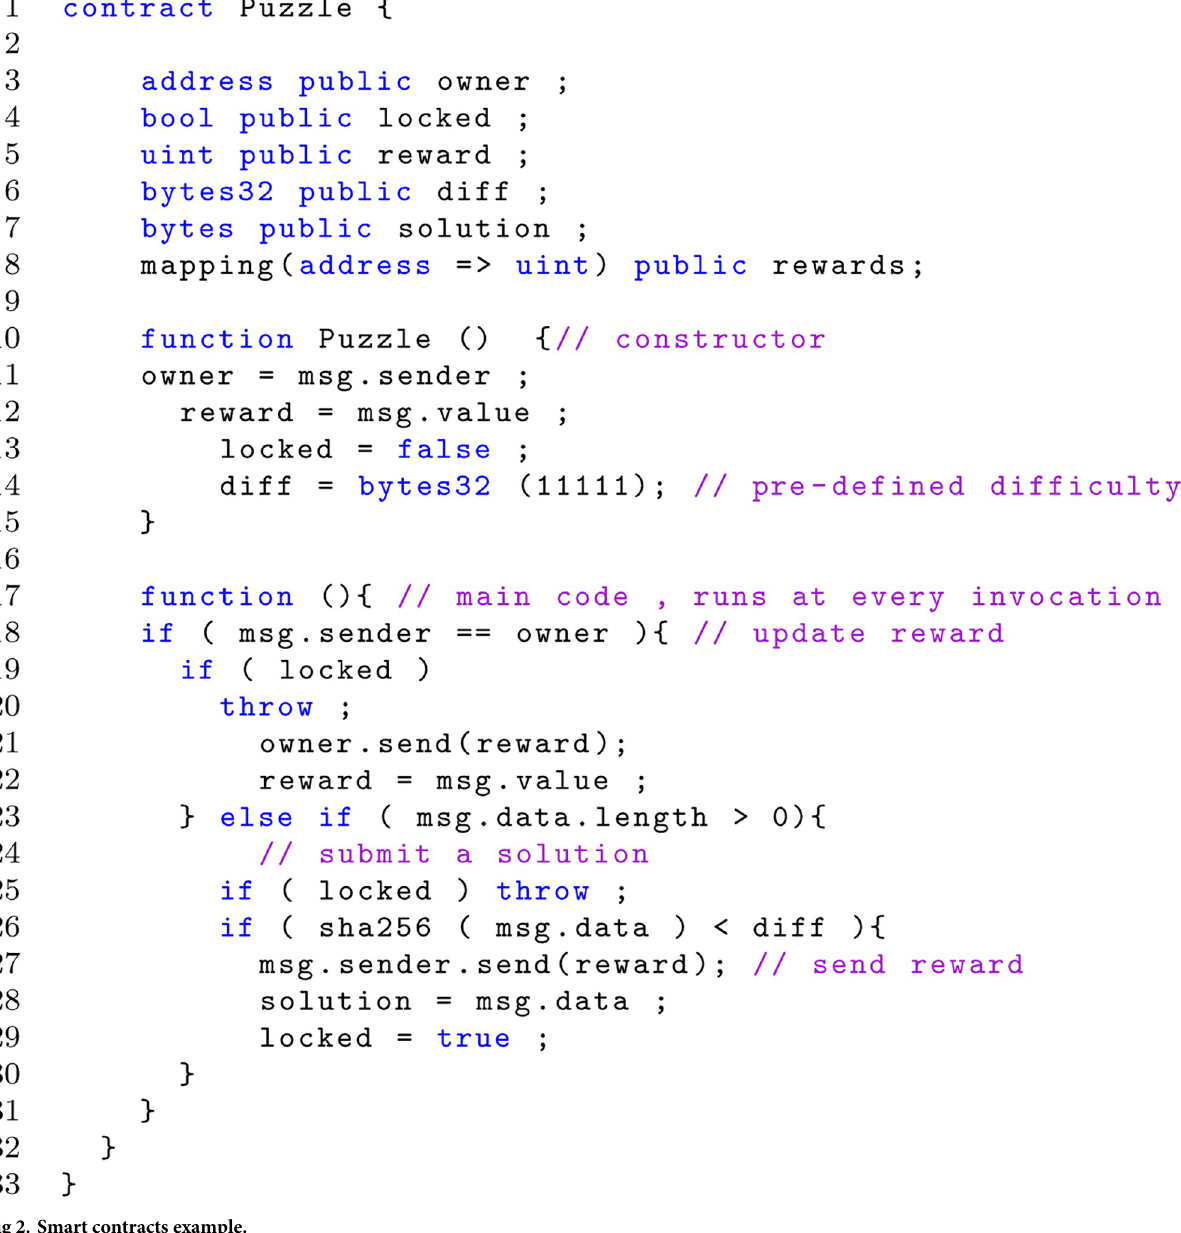
Fig 2. Smart contracts